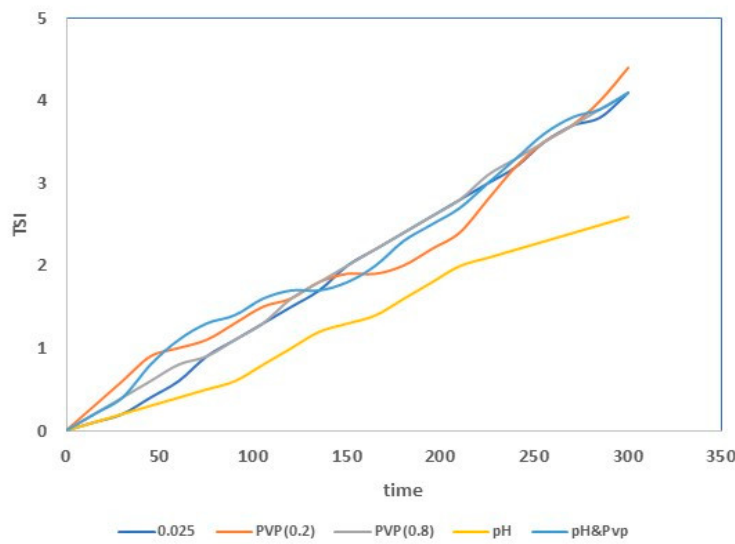
Figure 4. TSI values for the different prepared suspensions. Table 3. Zeta potential values for TiO 2 suspensions with and without additives.